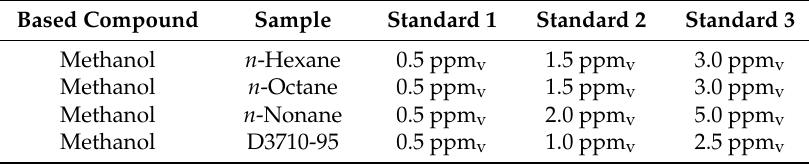
Table 2. Concentration of the standard for the quantification of VOC